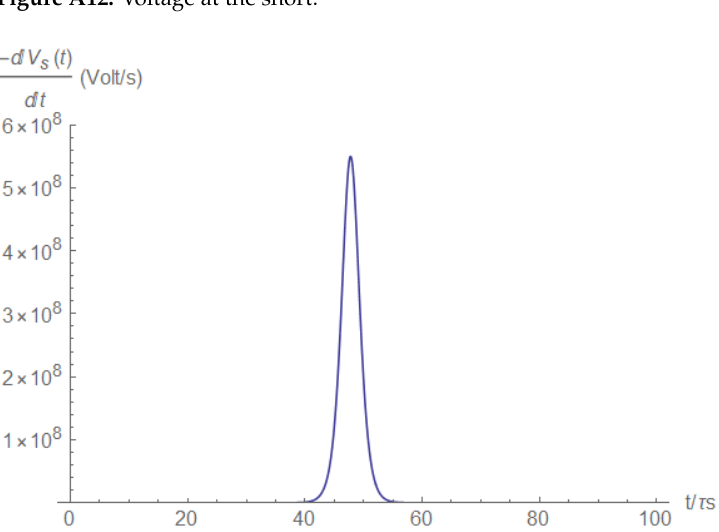
Figure A12. Voltage at the short.